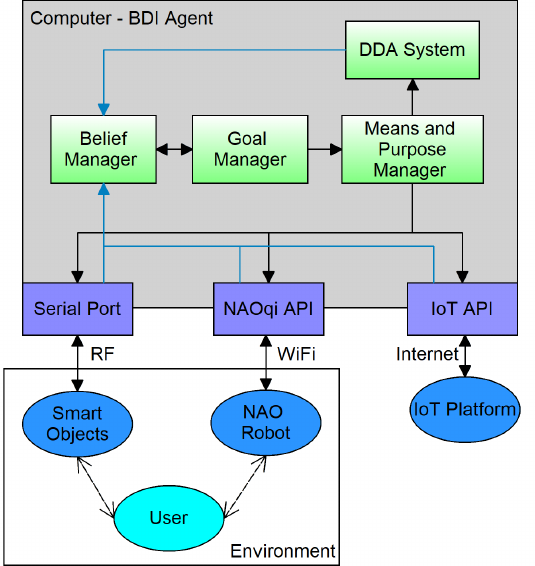
Figure 2. General modular diagram of the